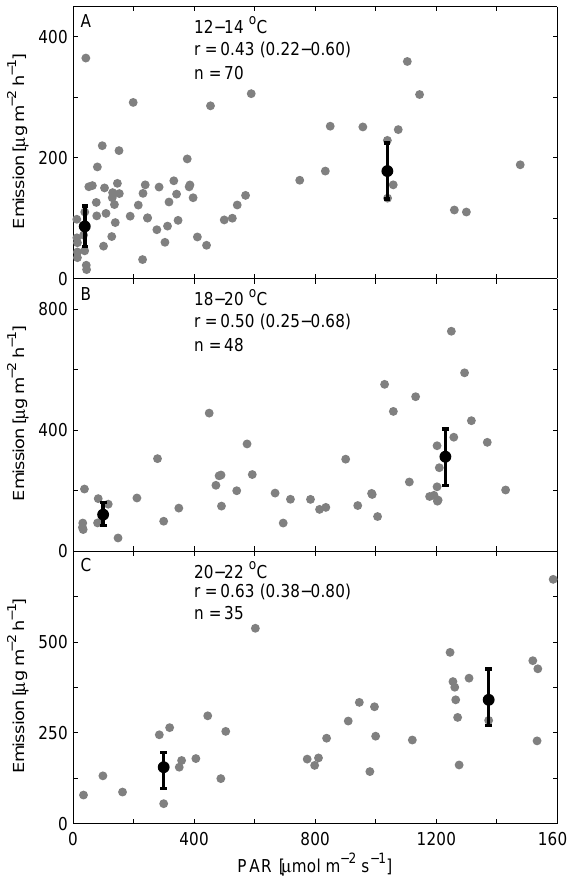
Fig. 2. Monoterpene emissions as a function of photosynthetically active radiation (PAR) in three temperature ranges. The grey dots show the individual measurements, r is the correlation coefficient, and n is the number of measurements. The black dots show the me- dians for the observations at low PAR (below the 25th percentile) and high PAR (above the 75th percentile). The numbers in paren- theses and the error bars represent the 95% confidence intervals. Only observations at PAR higher than 10µmolm − 2 s − 1 were in- cluded in the analysis.